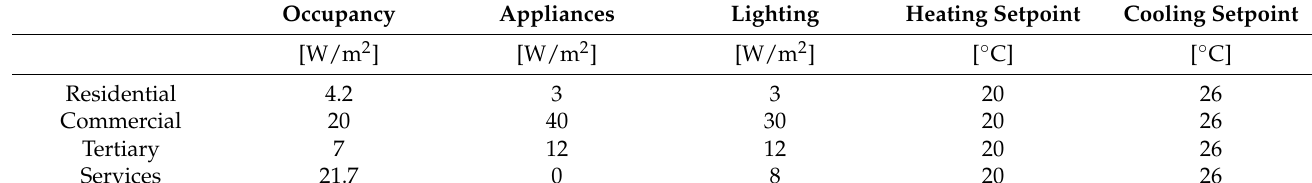
Table 4. End-uses nominal heat gains and setpoint.